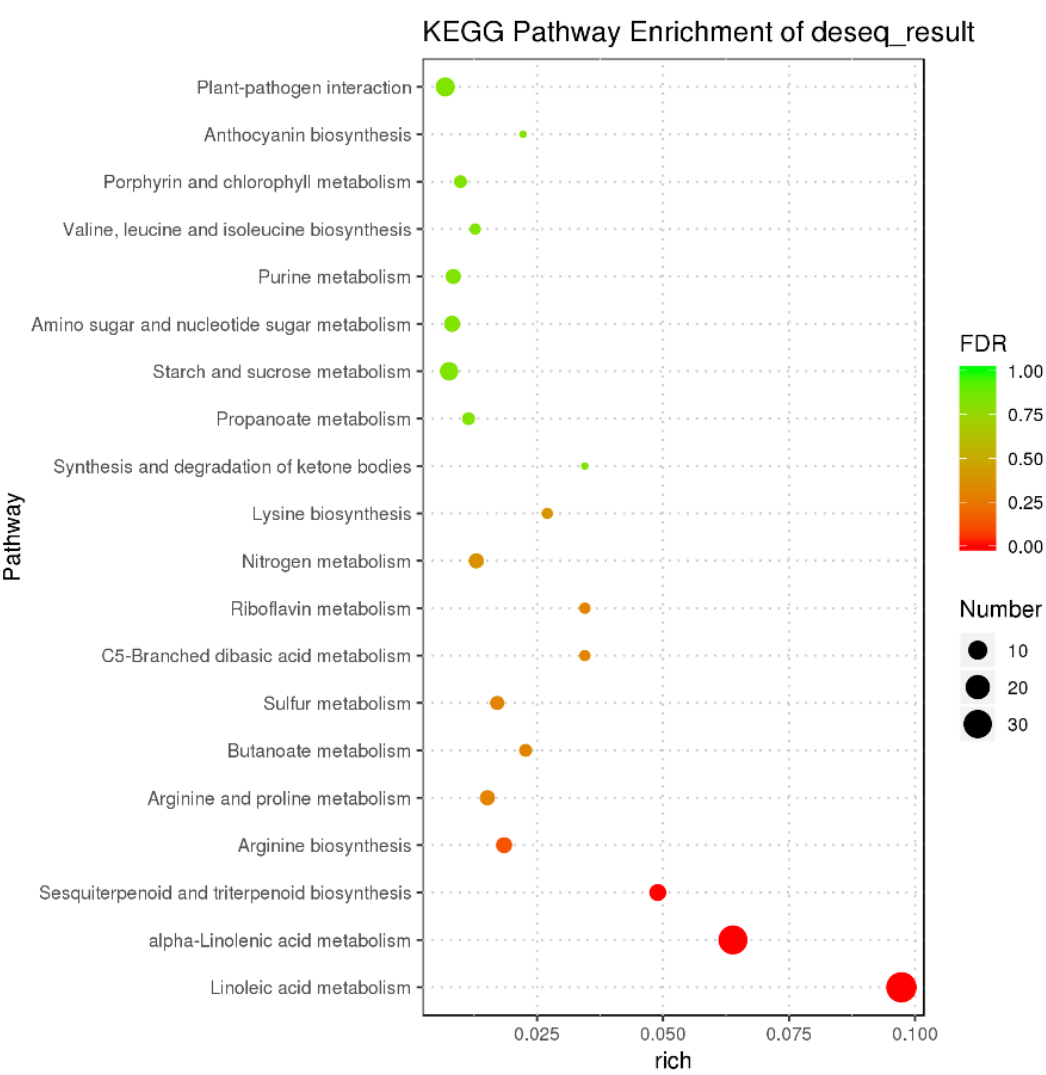
Figure 6. DEG analysis by the KEGG pathway of C. oleifera leaves under WL vs. BL.